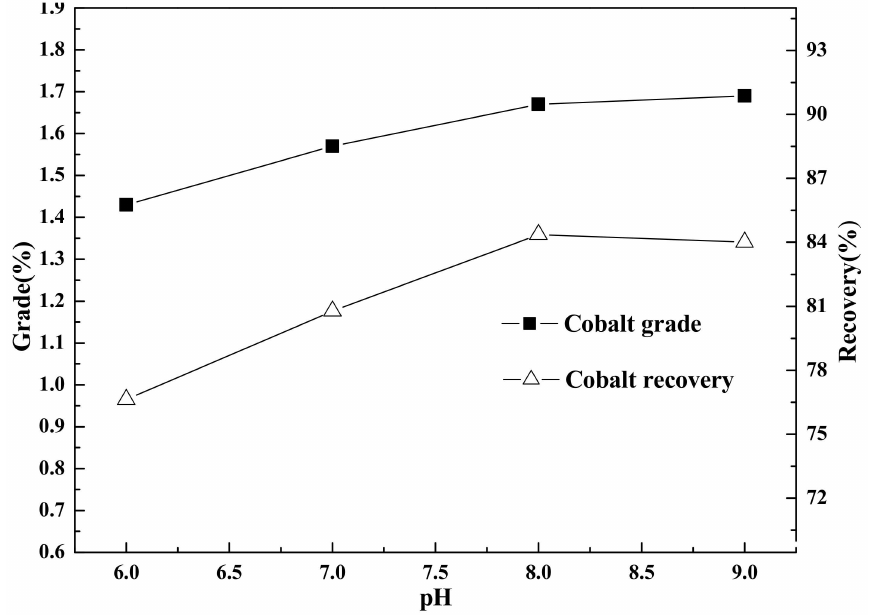
Figure 6. E ff ect of pulp pH on cobalt grade and recovery in